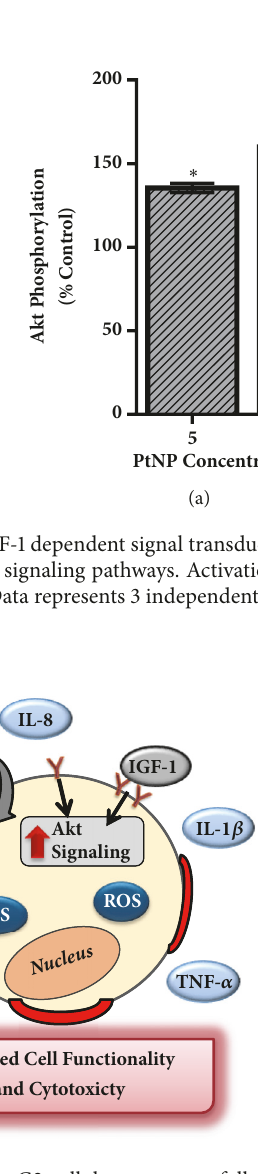
Figure 6: Summary of HepG2 cellular responses following PtNP exposure. This study identified that PtNPs induced traditional toxicological responses including cytotoxicity and stress activa- tion. Moreover, cellular functionality was modified as assessed via activation of an inflammatory response and modulation of IGF-1 dependent signal